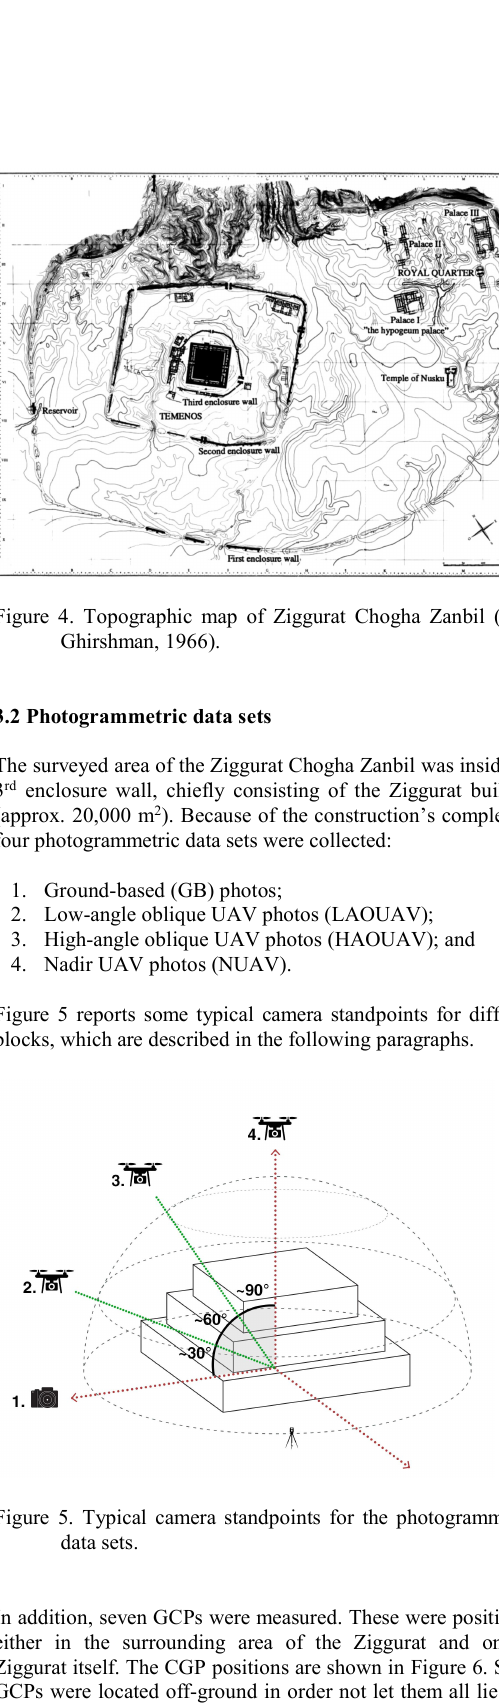
Figure 3. Aerial view of the Ziggurat Chogha Zanbil.